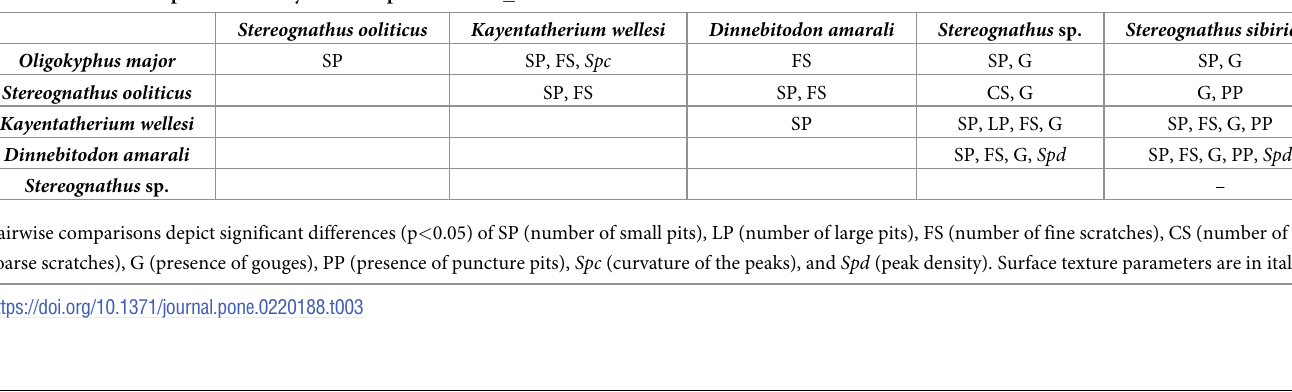
Table 3. Pairwise comparisons of tritylodontid species with N �